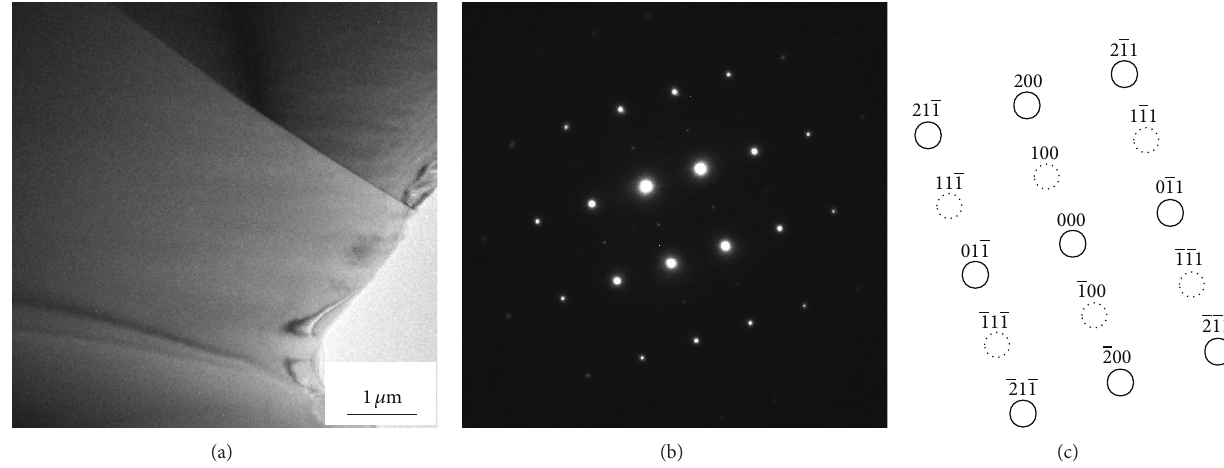
Figure 5: TEM micrographs of the heat treated Fe-6.5wt.%Si ribbons. (a) Bright-field image; (b) SADP of the zone axis of [001] ; (c) the corresponding schematic illustration, where solid circles represent A2 phase, and the dotted circles represent B2 phase.